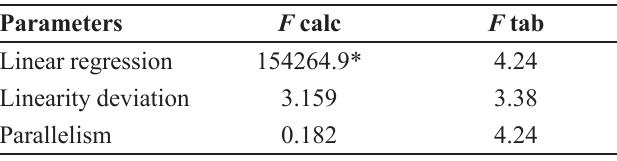
TABLE III - Analysis of variance of determination of CHX digluconate by bioassay Parameters F calc F tab Linear regression